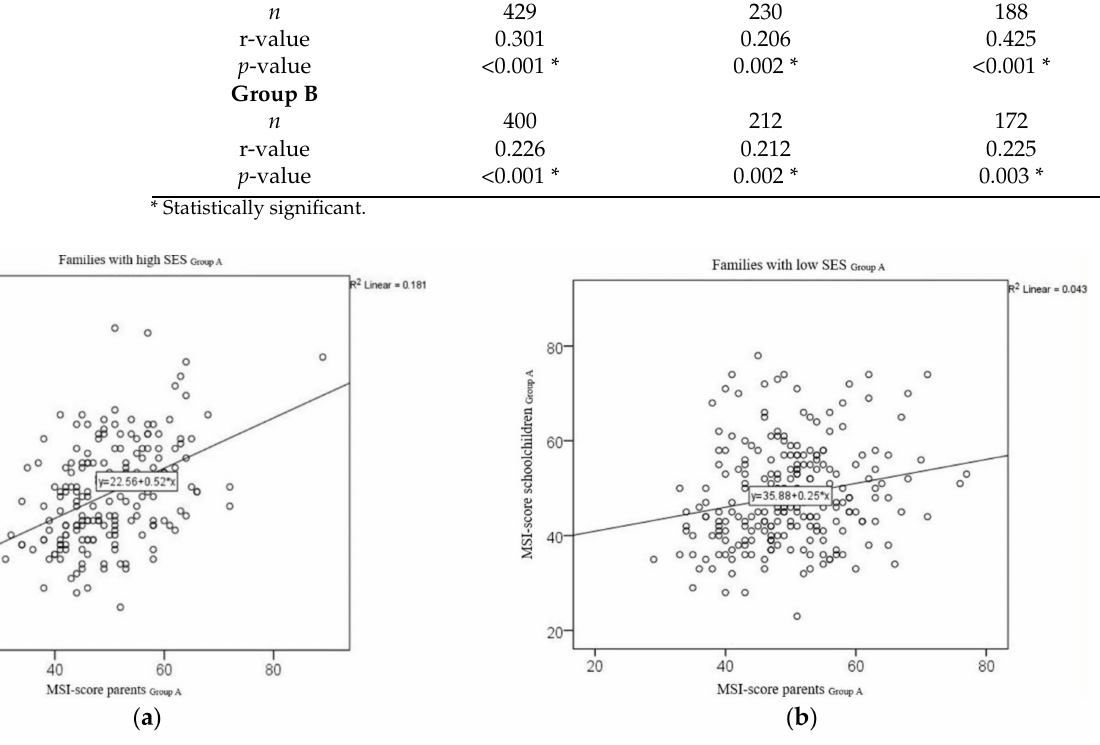
Figure 3. Correlation of the MSI scores for all parent–child pairs with different SES from Group A: ( a ) left—Group A, families with high SES; ( b ) right—Group A, families with low